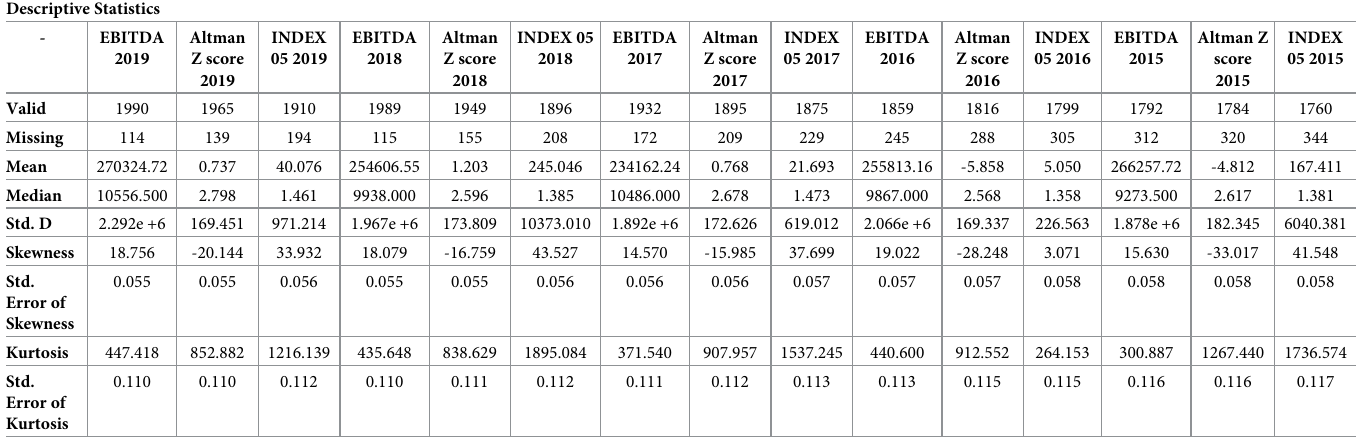
Table 3. Descriptive statistics of the statistical significance of differences in the